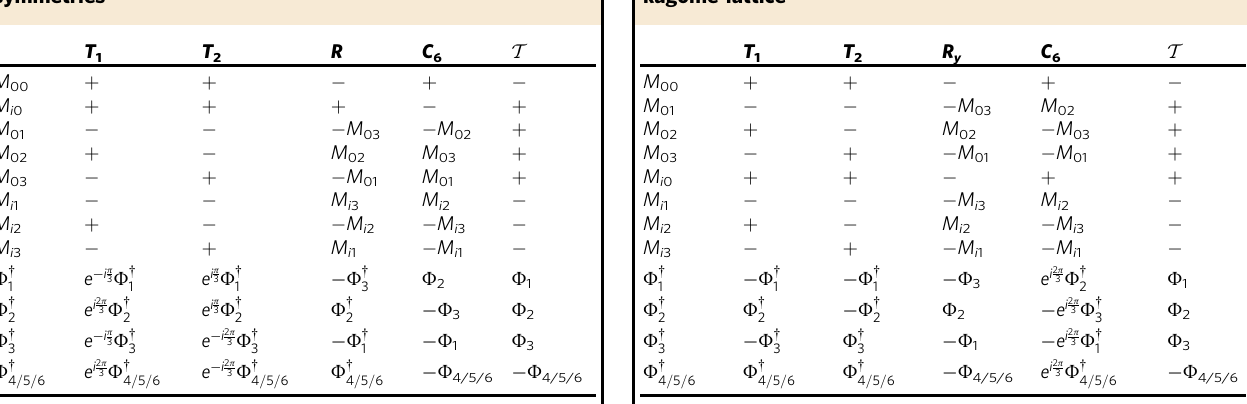
Table 2 Triangular lattice: fermion bilinears and monopole symmetries